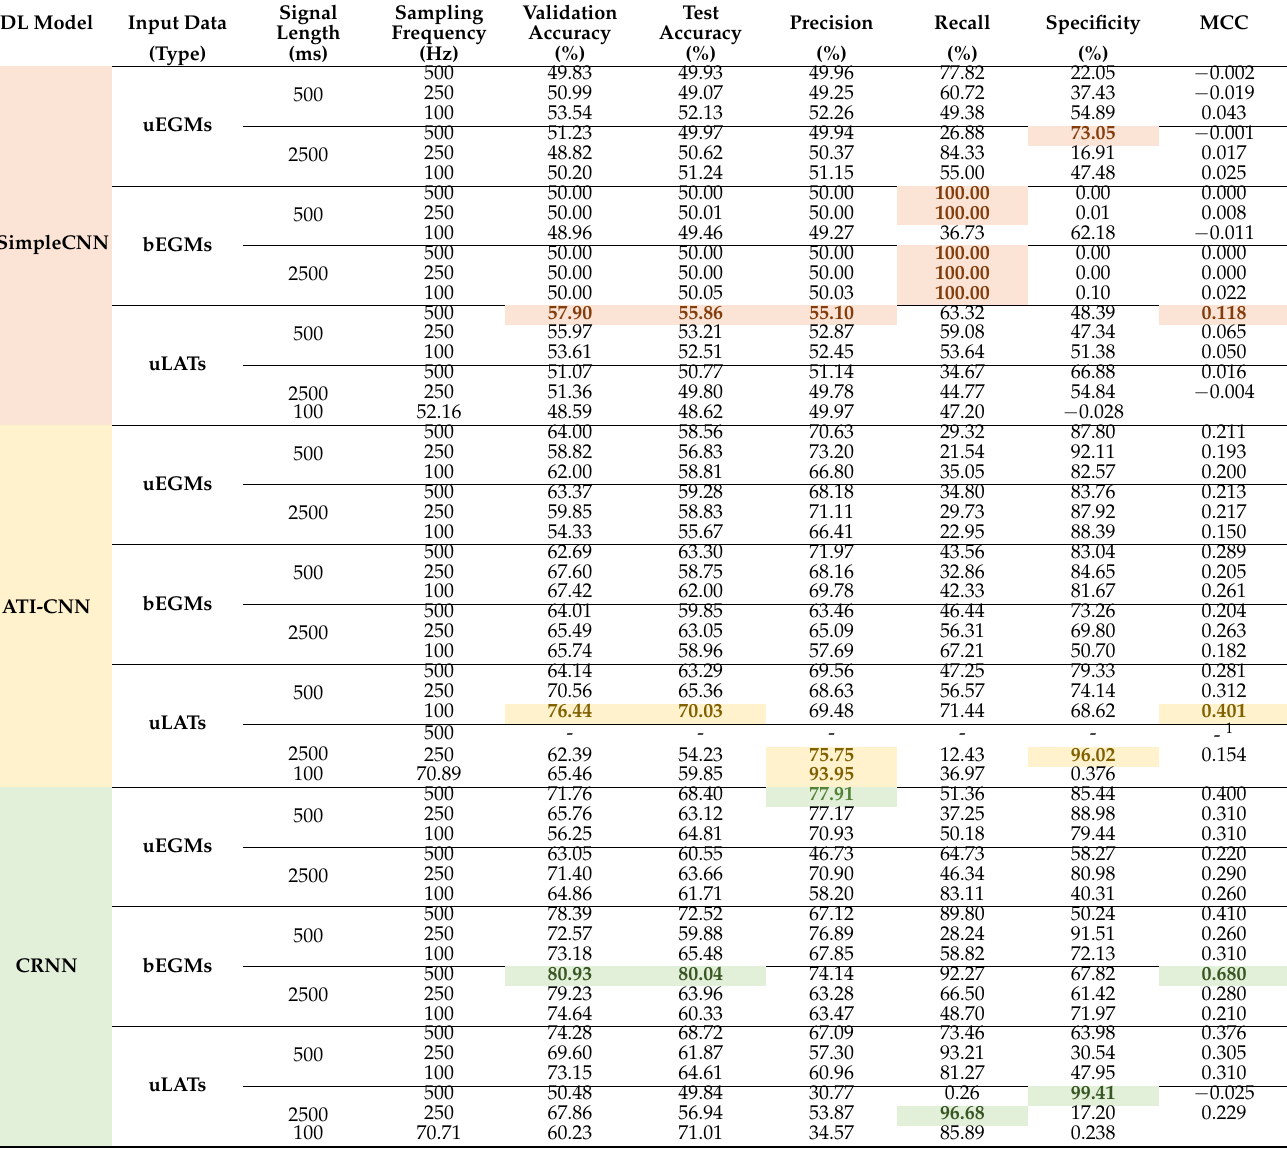
Table 2. Performance